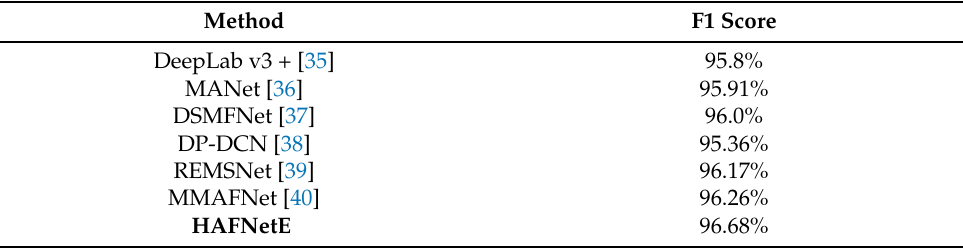
Table 4. F1-scores for state-of-the-art methods on the Potsdam dataset (building).